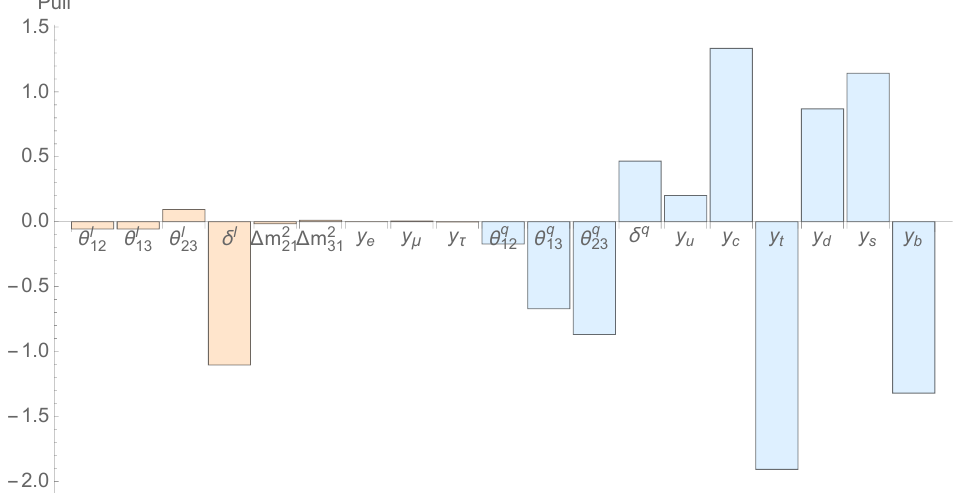
Figure 4. Pulls for the best (cid:12)t of model to data, as shown in tables 3{4, for lepton (light orange) and quark (blue) parameters.